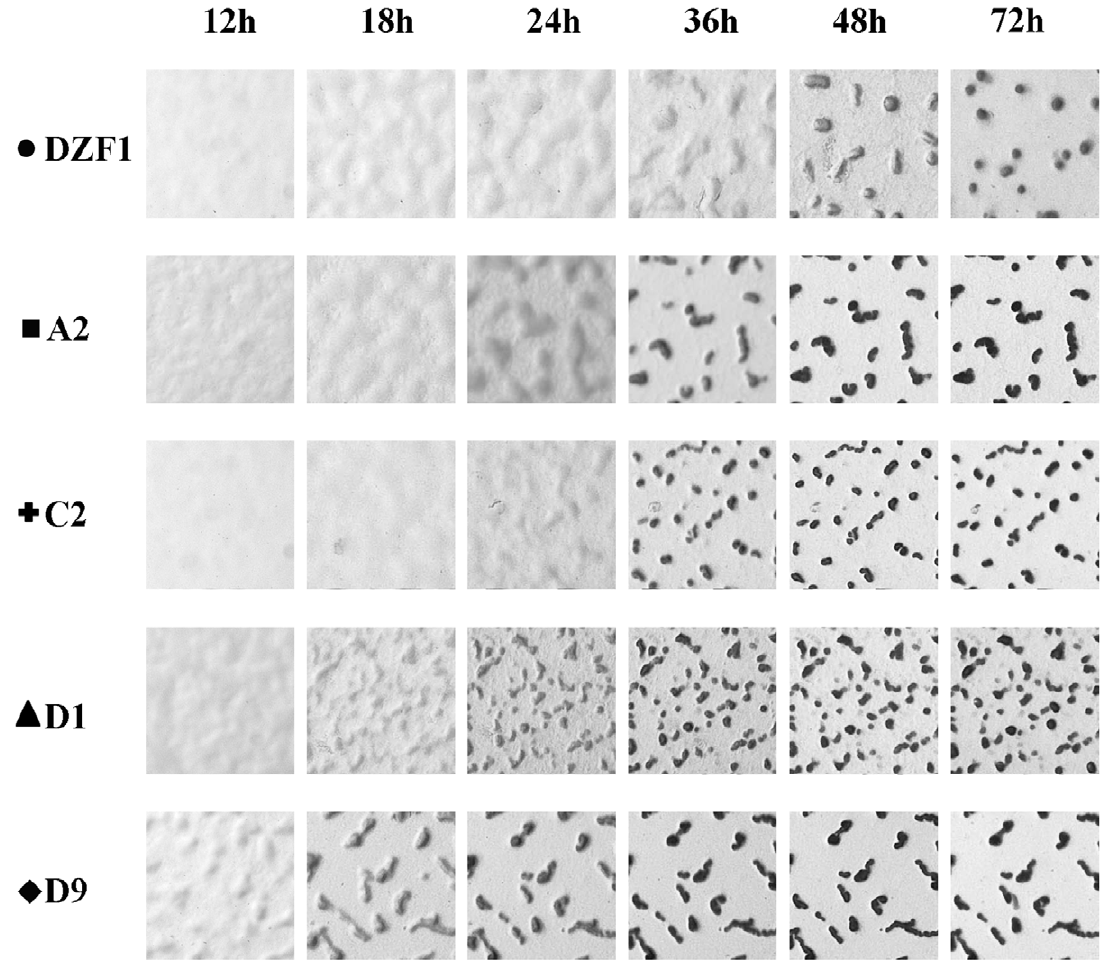
Figure 3. Myxococcus xanthus parental strain and knock-out mutants fruiting body formation at 12, 18, 24, 36, 48 and 72 h development. Micrographs were taken at 269.5 pixel/mm on TPM plates. Different mutations account for changes in developmental timing, which also has consequences in the final shape and distribution of fruiting bodies.